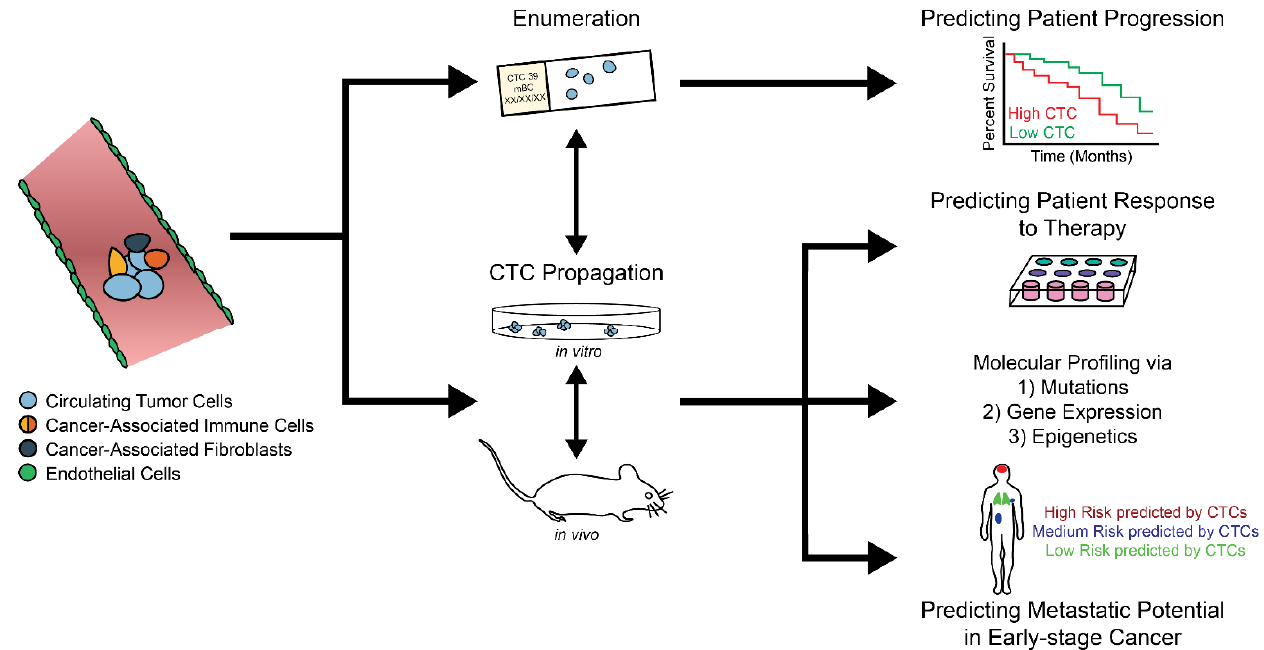
Figure 2. Potential applications of circulating tumor cell study.